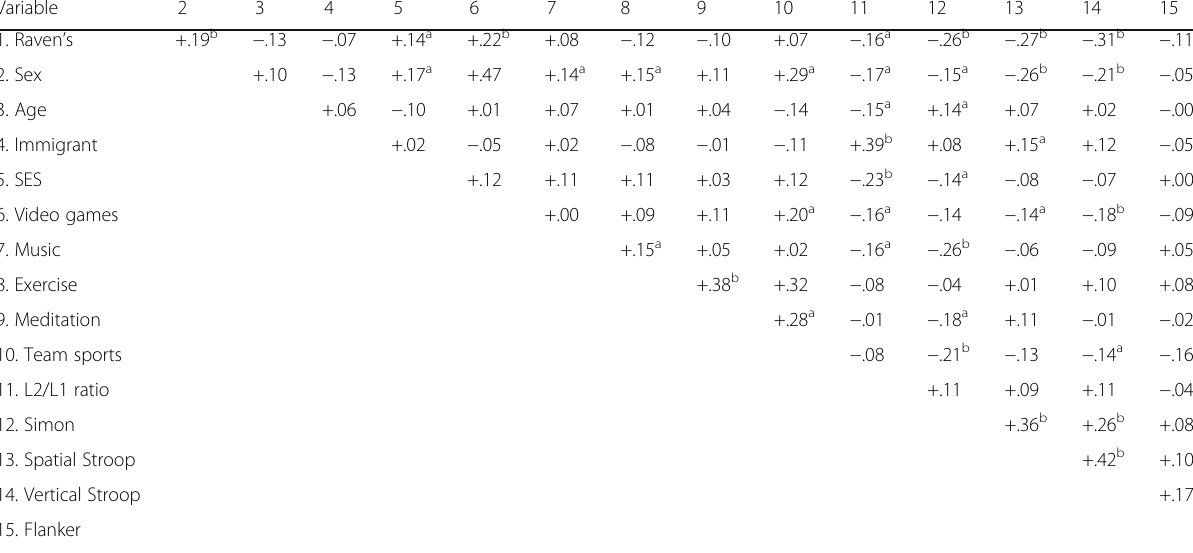
Table 8 Bivariate correlation matrix for set of 11 predictors and four outcome variables